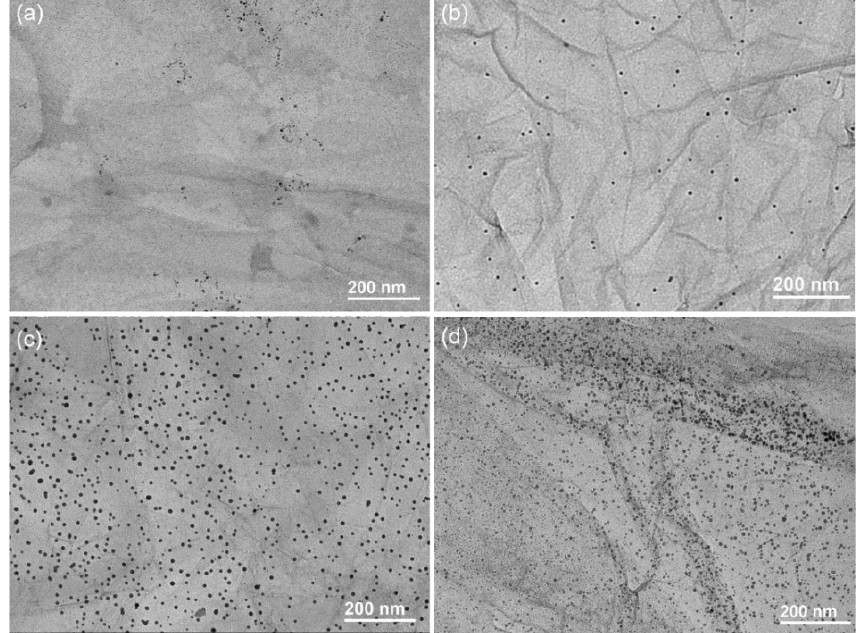
Figure 5. TEM images of GO/PNF/AgNP hybrid membrane suspensions with different AgNO 3 additions: ( a ) 15, ( b ) 25, ( c ) 50, and ( d ) 75 μL, respectively.